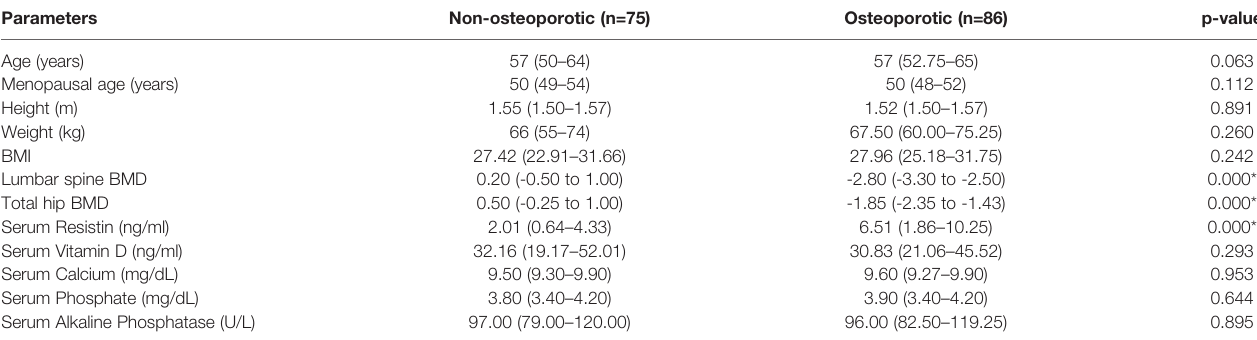
TABLE 1 | General, anthropometric, and biochemical parameters of study groups.